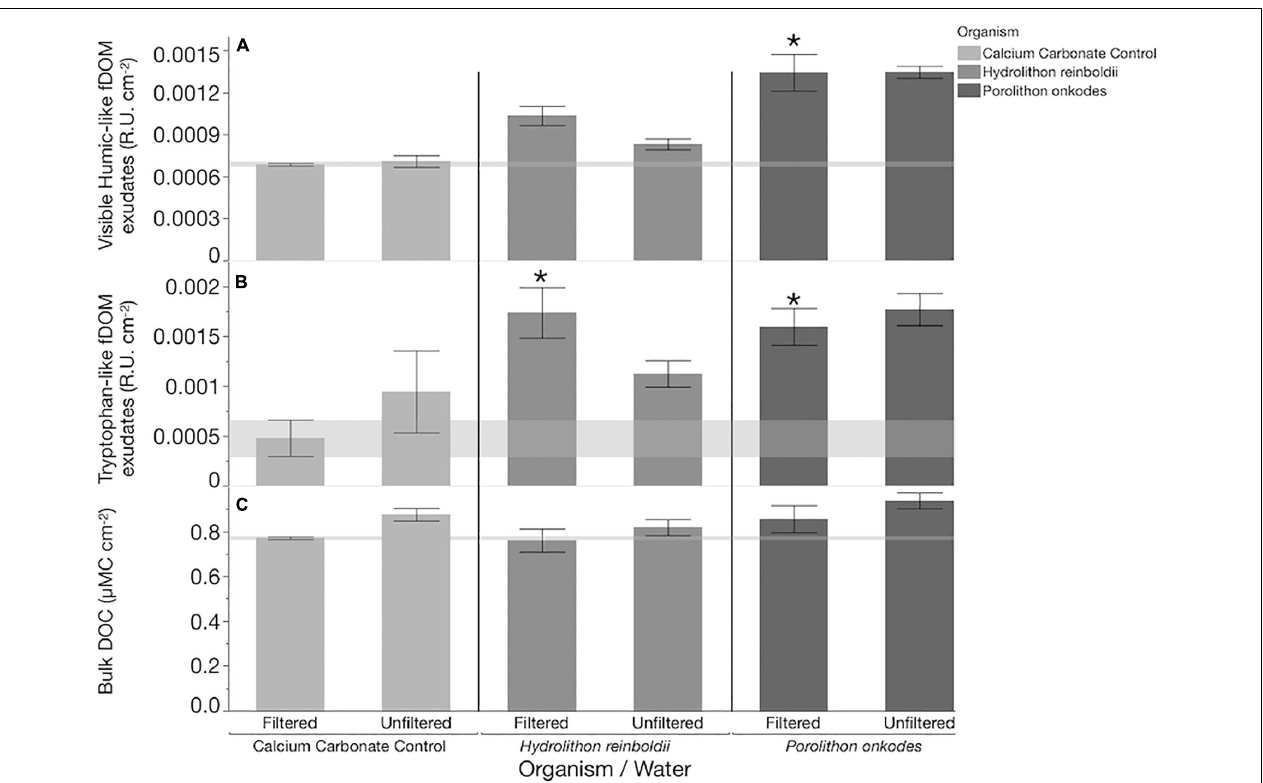
FIGURE 1 | DOM concentrations within each treatment after 8 h. Concentrations of (A) visible Humic-like fDOM exudates, (B) tryptophan-like fDOM exudates, and (C) bulk DOC are shown as bars (mean, n = 3, whiskers are SE). Shaded horizontal bands bracket mean and standard error of the calcium carbonate control for each parameter to illustrate background levels of DOM in filtered water treatments. R.U. is raman units of water. All treatments have had baseline levels (mean water control) of each fDOM variable subtracted before visualization. Before subtraction, exudates from each organism in both water treatments were significantly higher than levels within the water control (Dunnett’s FDR p < 0.0142) except for tryptophan-like fDOM within calcium carbonate controls (Dunnett’s FDR p > 0.05). “ ∗ ” indicate treatments which had significantly higher concentrations of exudate than the respective calcium carbonate control after water blank subtraction (Tukey FDR p <